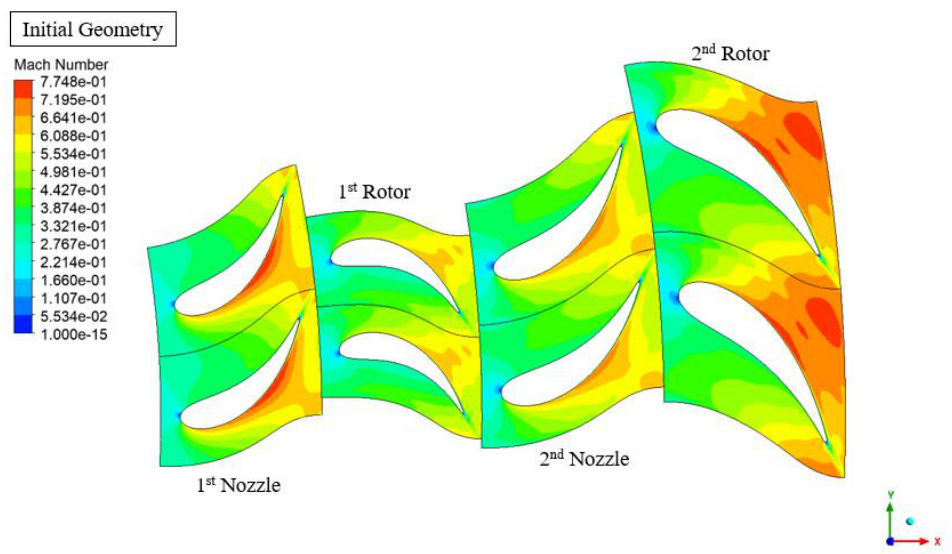
Figure 21. Mach number contour of the initial geometry.